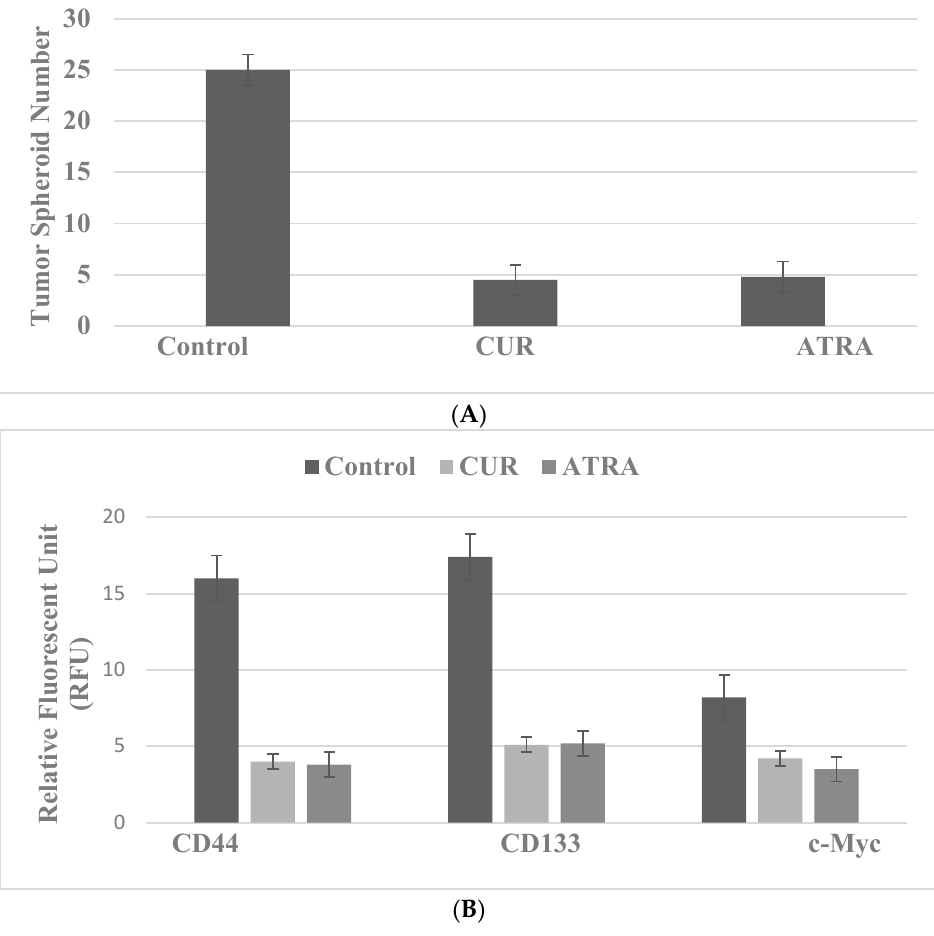
Figure 7. Inhibition of stem cell markers in the SUL-R 850 MIN COL model. ( A ) Treatment with CUR and ATRA decreased tumor spheroid number relative to the solvent control. ( B ) Treatment with CUR and ATRA inhibited the expression of CD44, CD133 and c-Myc relative to the solvent control. CUR, curcumin; ATRA, all-trans retinoic acid; CD44, cluster of differentiation 44; CD133, cluster of differentiation 133; c-Myc, cellular